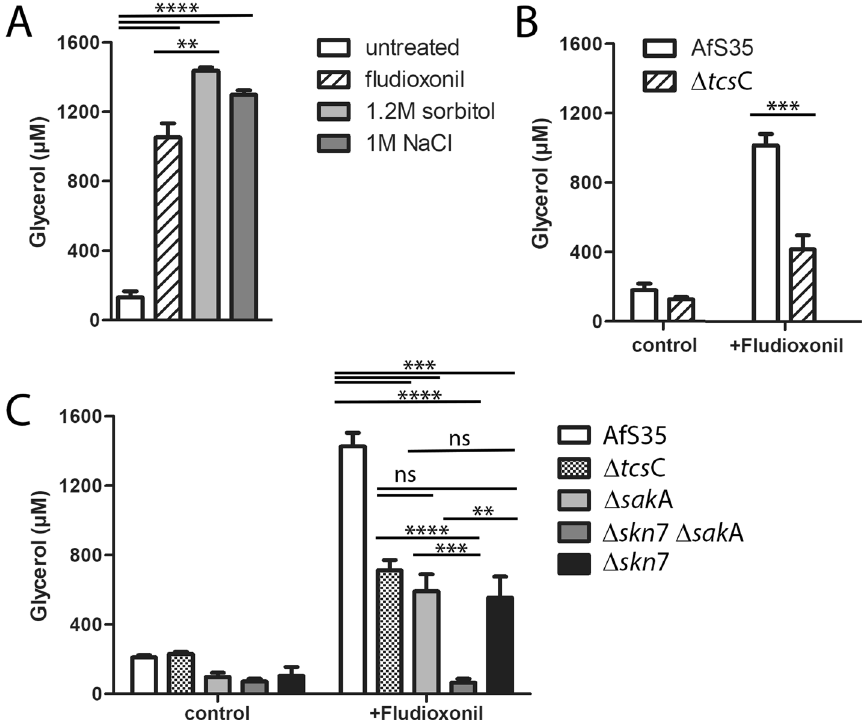
Figure 3. Changes of the intracellular glycerol concentration in response to different stress situations. (Panel A ) The A. fumigatus wild type responded to treatments with fludioxonil (1 µg/ml), 1.2 M sorbitol or 1 M NaCl with a similar increase of its intracellular glycerol concentration. (Panel B and C ) Fludioxonil (1 µg/ml) triggered a moderate increase in the intracellular glycerol concentrations of the Δ tcs C, Δ skn 7, Δ sak A and Δ ssk A mutants, whereas the Δ skn 7 Δ sak A mutant was non-responsive. Hyphae were pre-grown for 16 h at 30 °C. After addition of the stressor the incubation was prolonged for 6 h at 37 °C. The glycerol concentrations were determined for hyphal extracts adjusted to a protein concentration of 100 µg/ml. Data were analyzed using a Student’s t-test (**: p < 0.01, ***: p < 0.001, ****: p <